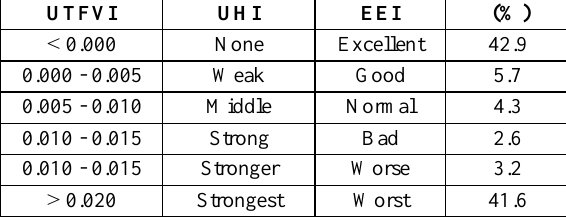
Table 6: Threshold of ecological evaluation index